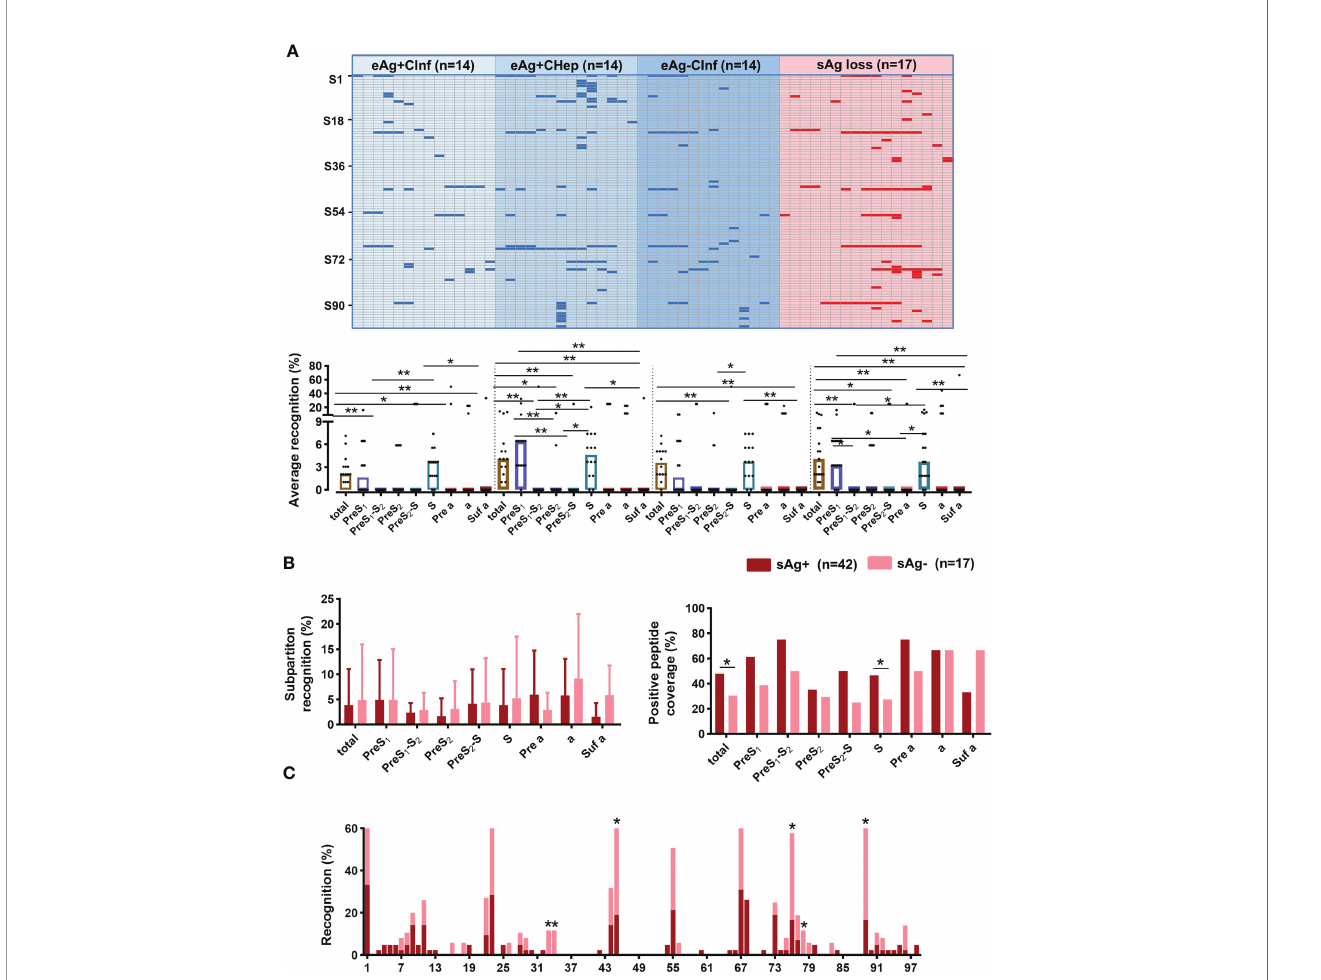
FIGURE 3 | Screening sera from patients with chronic HBV infection. (A) Sera from patients with chronic HBV infection were diluted (1:100) and incubated with a peptide array, followed by incubation with HRP-conjugated anti-human IgG. The peptide array was visualized by chemiluminescent reagents, scanned, and quanti fi ed. Peptides with a signal above 1500 (mean +3 SD of the negative control) were counted as positive (blue and red bars). The positive peptides for each subject were plotted. Comparing the average recognition rate of each peptide in subpartitions in patients with chronic HBV infection. (B) Comparison of the subpartition recognition rate (a set of recognition rates in the subpartition of each patient) and positive peptide coverage between the sAg + and sAg - groups. (C) Comparison of the recognition rate of each peptide between sAg + and sAg - groups. (A) Kruskal – Wallis H test and Dunn ’ s multiple comparisons test. (B) Mann – Whitney U test (left) and Chi-square test (right). (C) Chi-square test. * P < 0.05, ** P <